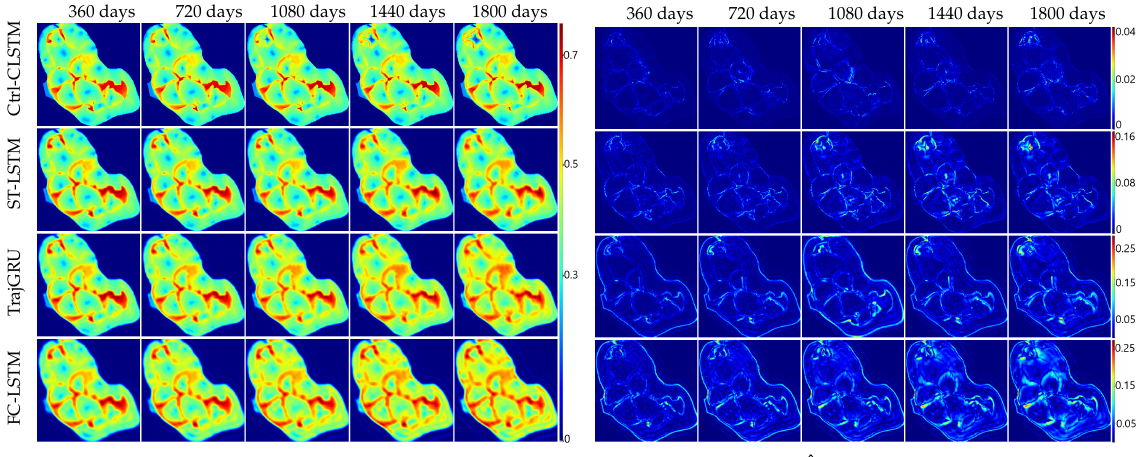
Figure 4. Input sequence and numerical simulation sequence.